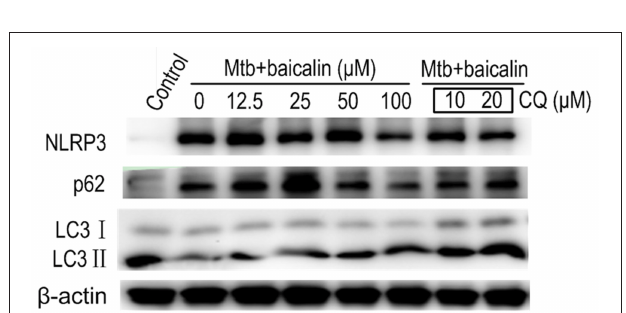
FIGURE 6 | Baicalin inhibits the expression of Mtb-induced NLRP3 in primary peritoneal macrophage cells and chloroquine (CQ) prevented this effect. The expression of NLRP3, LC3 I/II and p62 in Mtb-infected primary peritoneal macrophage cells after treatment with different concentrations of baicalin or CQ (10, 20 µ M) was detected by Western blot. The concentration of baicalin when used in combination with CQ was 100 µ